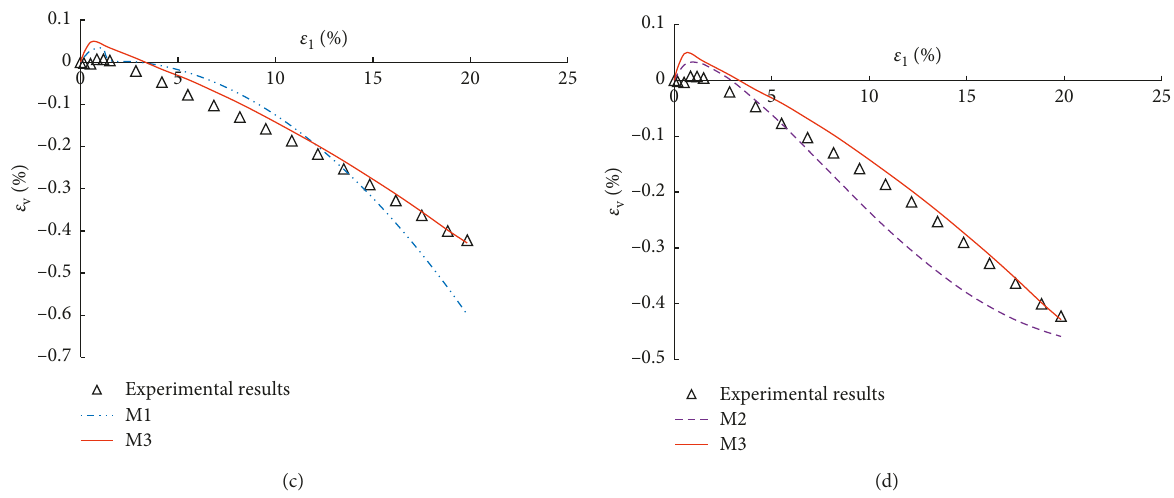
Figure 11: Volumetric strain-axial strain relationship fitting results for each model at − 3 ° C. Comparison between experimental results and calculated results of (a) M1 and M3 ( T � − 3 ° C, σ 3 � 1.0 MPa), (b) M2 and M3 ( T � − 3 ° C, σ 3 � 1.0 MPa), (c) M1 and M3 ( T � − 3 ° C, σ 3 � 8.0MPa), and (d) M2 and M3 ( T � − 3 ° C, σ 3 � 8.0MPa).